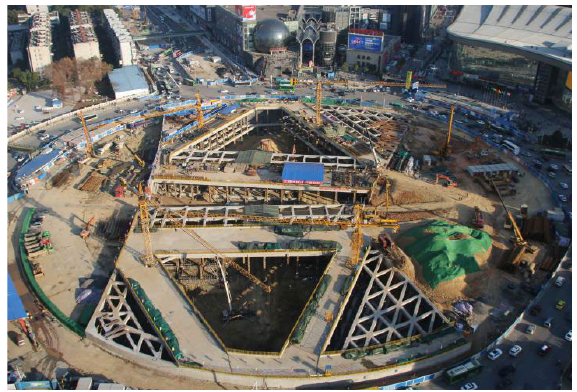
Figure 1. Excavation site of LDCFP construction.